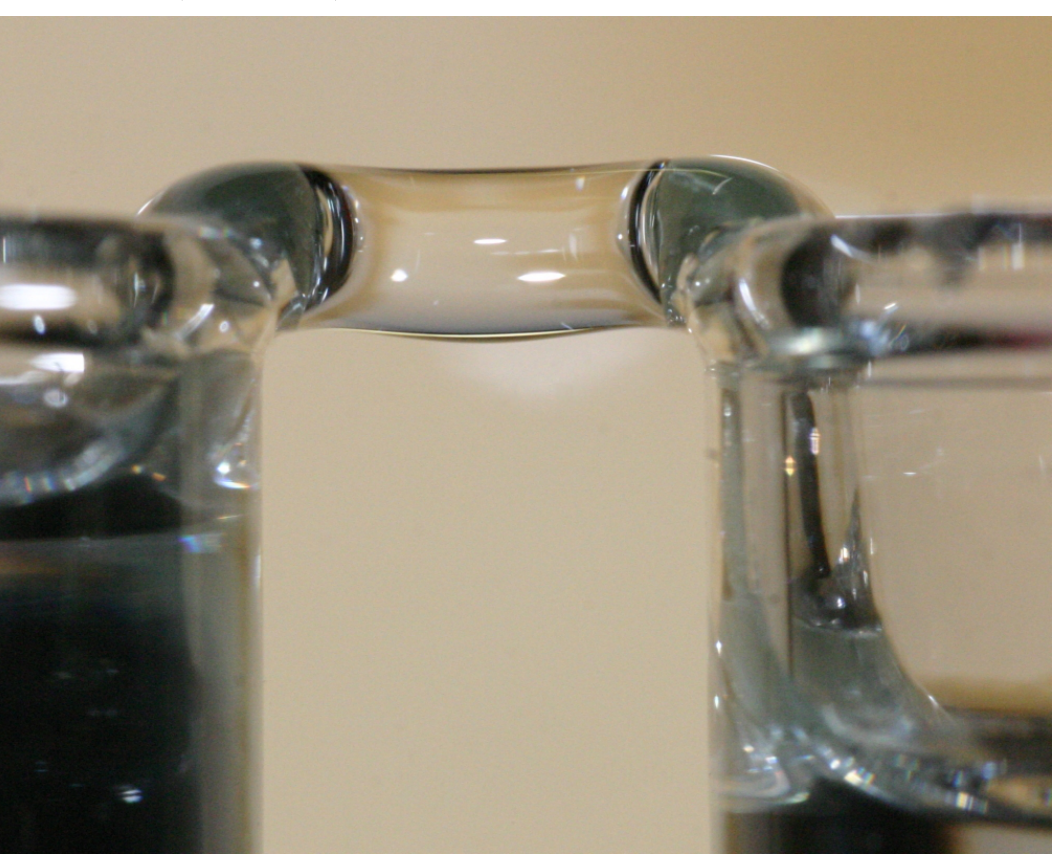
Figure 2. A floating water bridge produced with glass beakers, deionized water, Pt electrodes, 15kV (see also